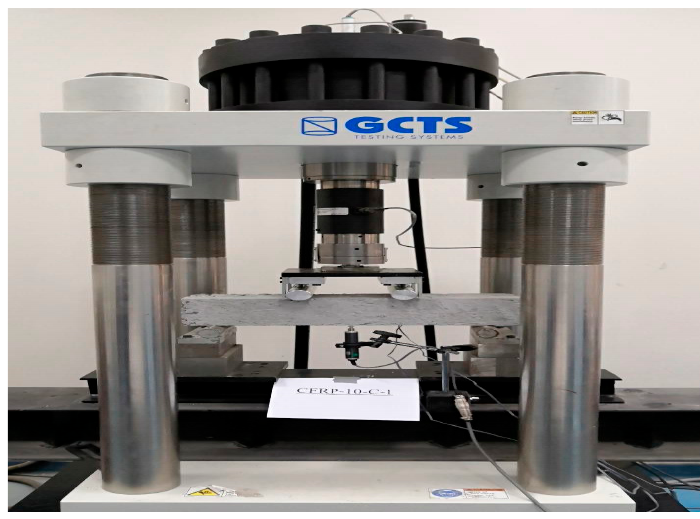
Figure 3. Experimental setup to test the specimen.